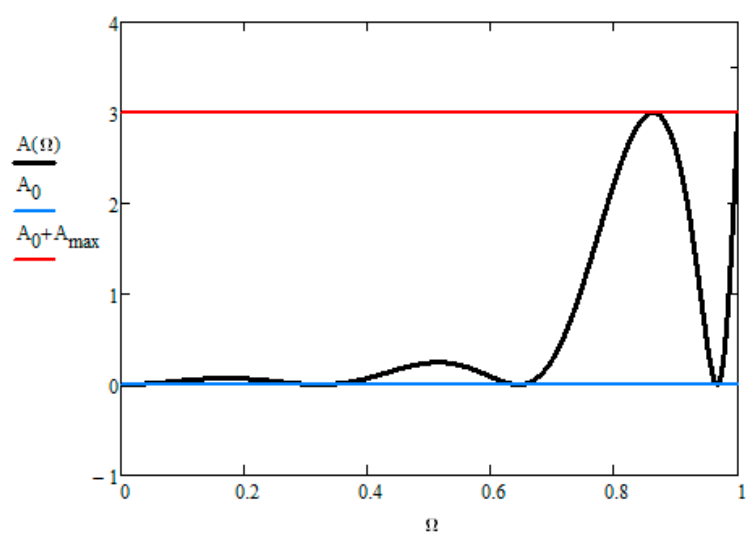
Figure 4. Passband attenuation of Low-pass Pascal filters N = 7.